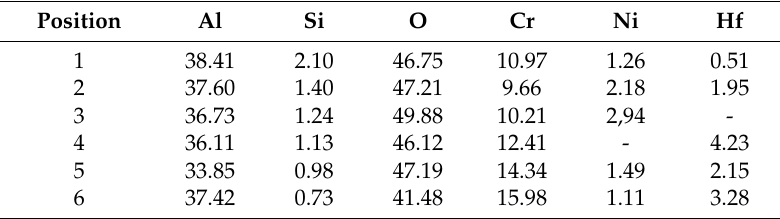
Figure 12. Macroscopical photos and cross-sectional SEM images of as-casted DZ22B alloy blades. ( a ) Blade photo (facecoat: fused alumina+ 2 wt.% Cr 2 O 3 ); ( b ) interfacial area image (facecoat: fused alumina+ 2 wt.% Cr 2 O 3 ); ( c ) blade photo (facecoat: fused alumina+ 5 wt.% Cr 2 O 3 ) and ( d ) interfacial area image (facecoat: fused alumina+ 5 wt.% Cr 2 O 3 ). Table 5. EDS analysis of the positions in Figure 11b,d (at.%).